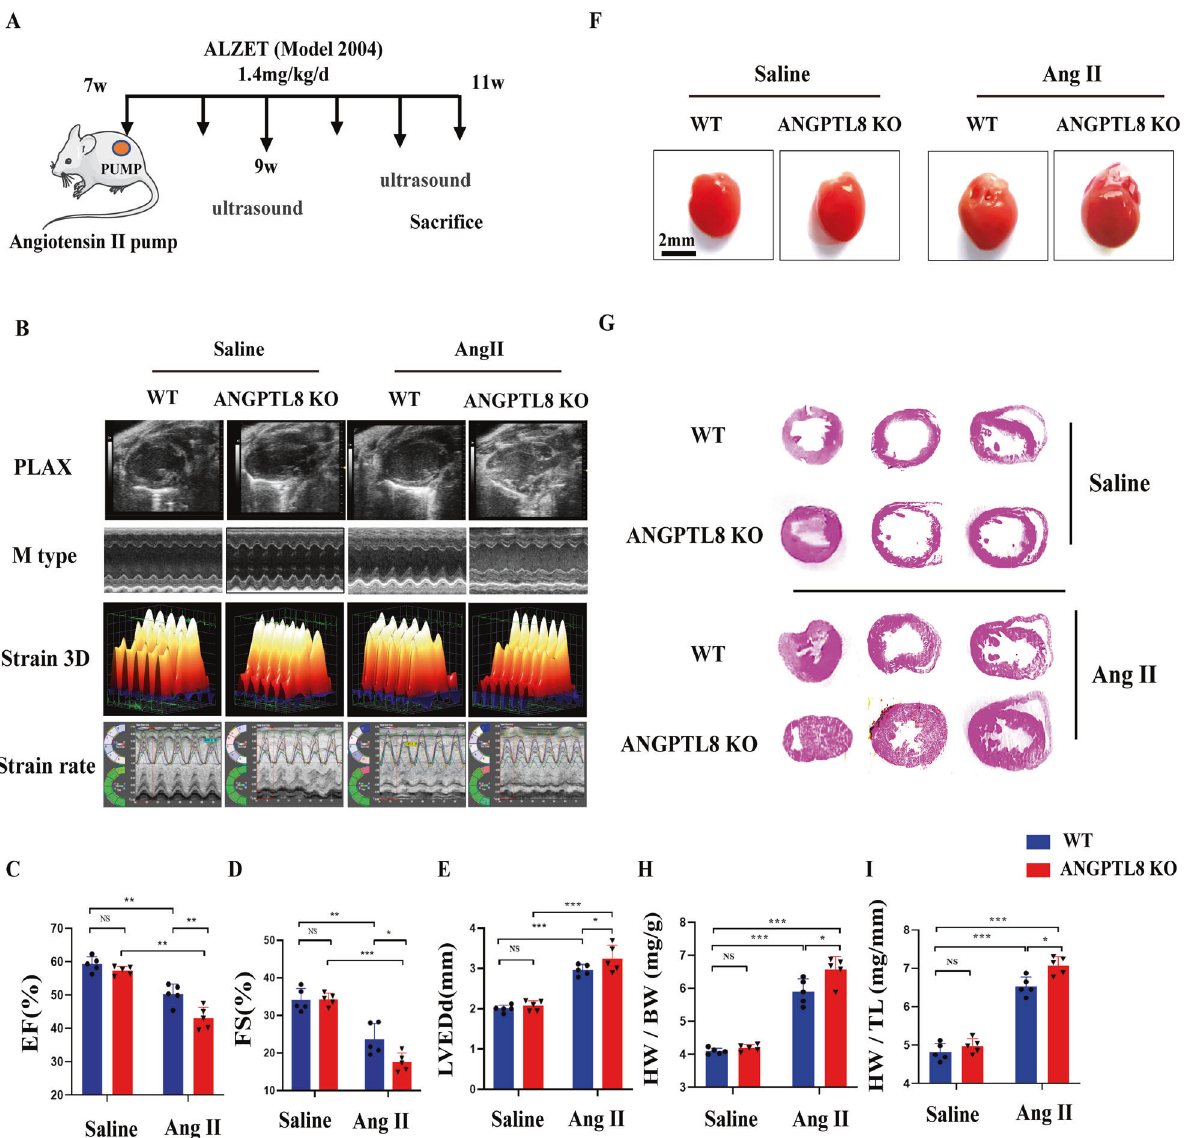
Fig. 2 ANGPTL8 de fi ciency accelerated cardiac hypertrophy induced by Ang II infusion. A Cardiac hypertrophy in mice was induced by Ang II infusion for 4 weeks. B Echocardiographic assessments of cardiac function in WT and ANGPTL8-KO mice at 4 weeks of Ang II infusion. PLAX = Long axis of the heart, M model (M type), Three-dimensional deformation ability (Strain 3D&strain rate), n = 4~6 per group. C – E Ejection fraction (EF%), fraction shortening (FS%) and left ventricular end-diastolic dimension (LVEDd) were assessed by echocardiography in WT and ANGPTL8-KO mice at 4 weeks after saline or Ang II infusion ( n = 5, NS no signi fi cant difference, *P < 0.05, ** P < 0.01, *** P < 0.001). F Representative images of the gross cardiac morphology used for HW/BW and HW/HL calculation (scale bar, 2 mm) ( n = 5). G Representative images of transverse sections stained with H&E (scale bar, 0.5 cm, n = 5). H , I Bar graphs showing quantitative data for HW/BW or HW/TL ( n = 5 per group, NS no signi fi cant difference, *P < 0.05, *** P <